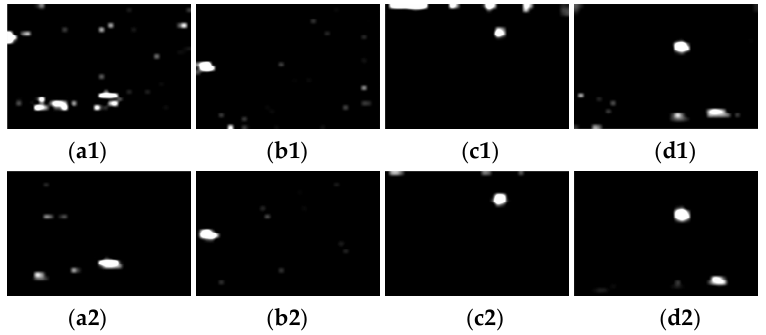
Figure 12. ( a1 – d1 ) are the saliency maps obtained by the VAM method proposed by ITTi, ( a2 – d2 ) are the saliency maps after applying the above improved method.